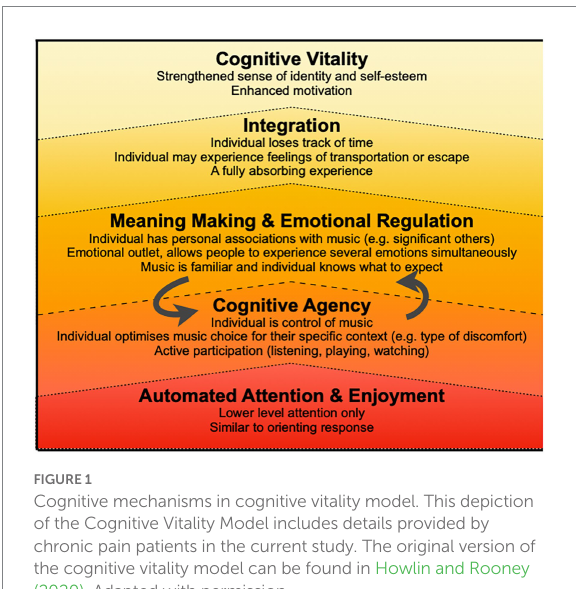
FIGURE 1 Cognitive mechanisms in cognitive vitality model. This depiction of the Cognitive Vitality Model includes details provided by chronic pain patients in the current study. The original version of the cognitive vitality model can be found in Howlin and Rooney (2020). Adapted with